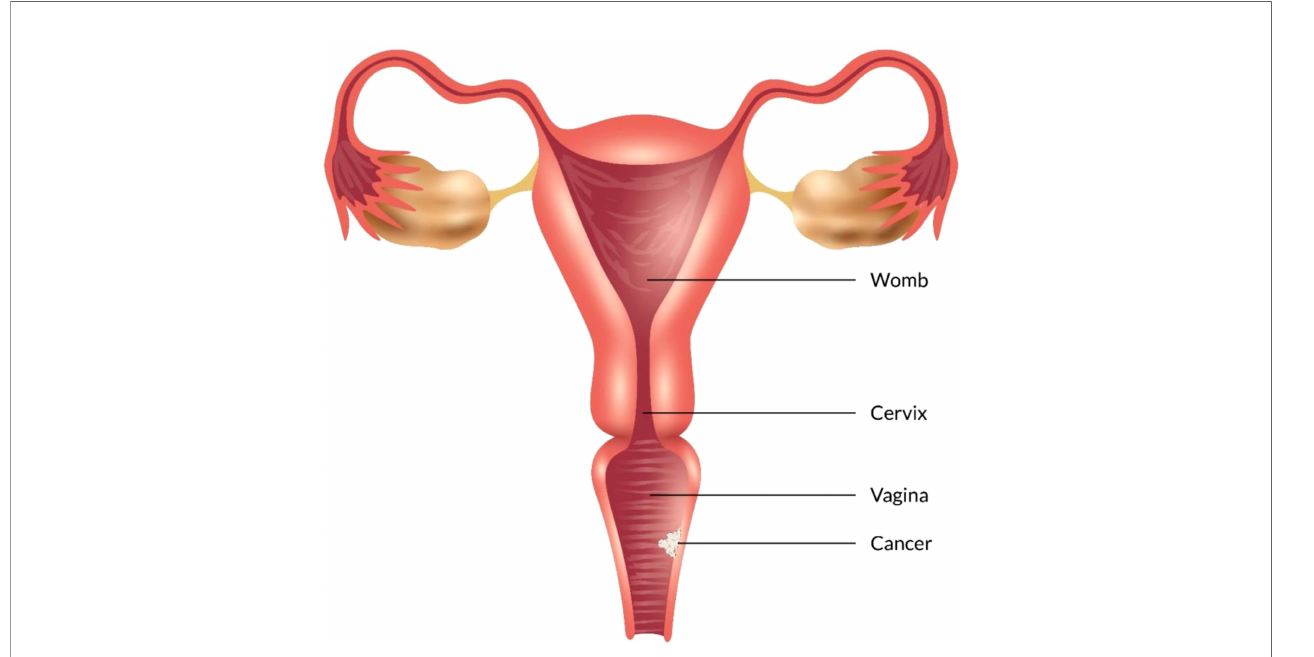
FIGURE 4 | Vaginal Cancer Stage